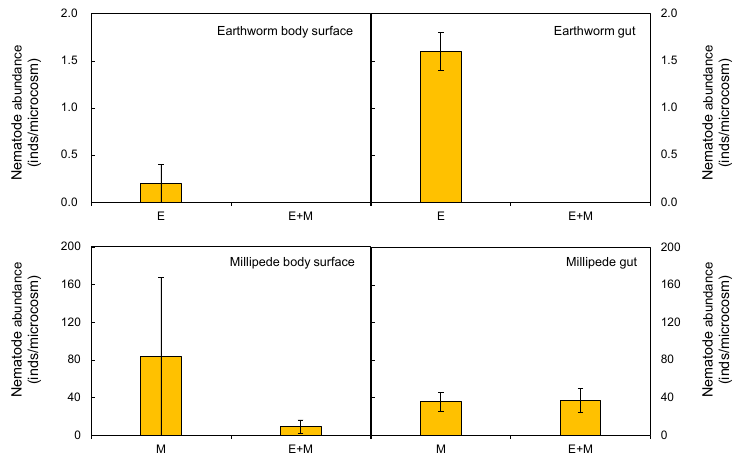
Figure 4. Abundances of the nematodes on the body surfaces or in the guts of earthworms and millipedes in each microcosm. Data represent means ± SE (n = 5).